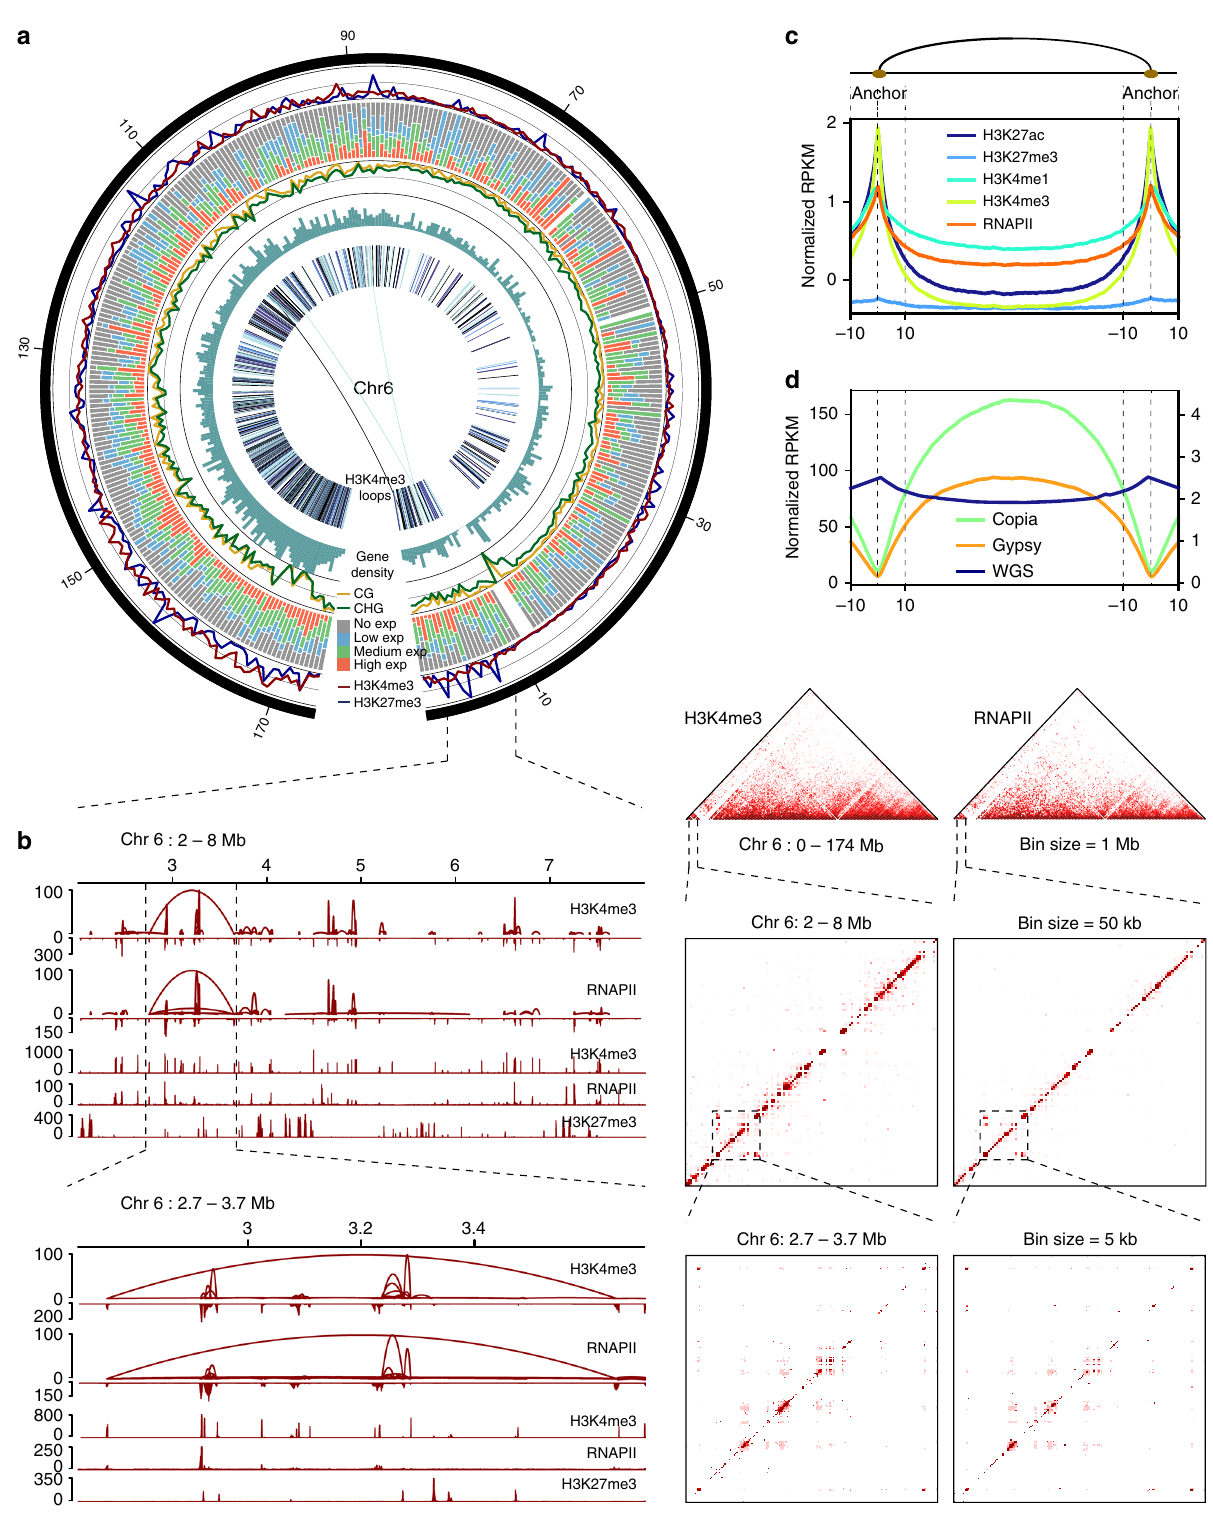
Fig. 2 Characterization of RNAPII and H3K4me3 ChIA-PET data in maize seedlings. a Circos plot, with circles from outside to inside indicating histone modi fi cation (H3K4me3 and H3K27me3), gene expression (no expression, low expression, median expression, and high expression), DNA methylation (CG and CHG), gene density, and H3K4me3 interactions at 500 kb resolution on chromosome 6. b Detailed analysis of the 2 – 8 Mb region on Chr.6. Left panel: loop/peak view of H3K4me3 and RNAPII at indicated regions, with contact frequency in the loop or intensity of combined peaks indicated on the y - axis. Right panel: H3K4me3 and RNAPII contact heatmap. c Histone modi fi cations, RNAPII occupancy, transposable elements, and MNase hypersensitivity around PPI anchors and loops. The x axis indicates a loop between anchors ± 10%, while the y axis indicates RPKM value. d Distribution of transposable elements Copia and Gypsy around PPI anchors and loops. y -Axis represents the normalized RPKM for the content of Copia and Gypsy (left) and whole genome sequencing (WGS) reads